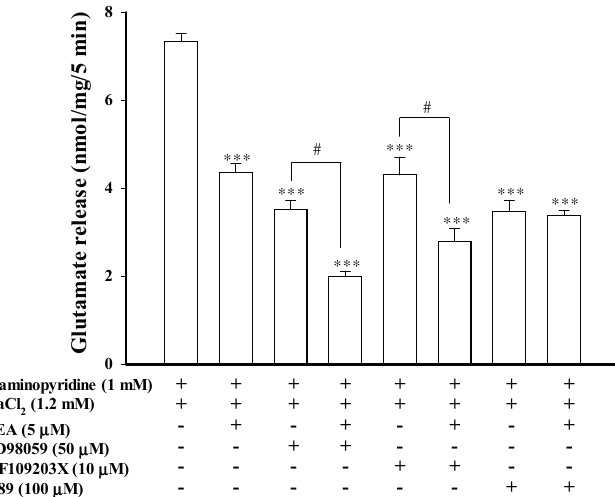
Figure 5. PEA-mediated inhibition of evoked glutamate release is prevented by the PKA inhibitor H89. Bar graph showing glutamate release induced by 1 mM 4-aminopyridine in the absence (control) or presence of 5 μ M PEA, 50 μ M PD98059, 50 μ M PD98059